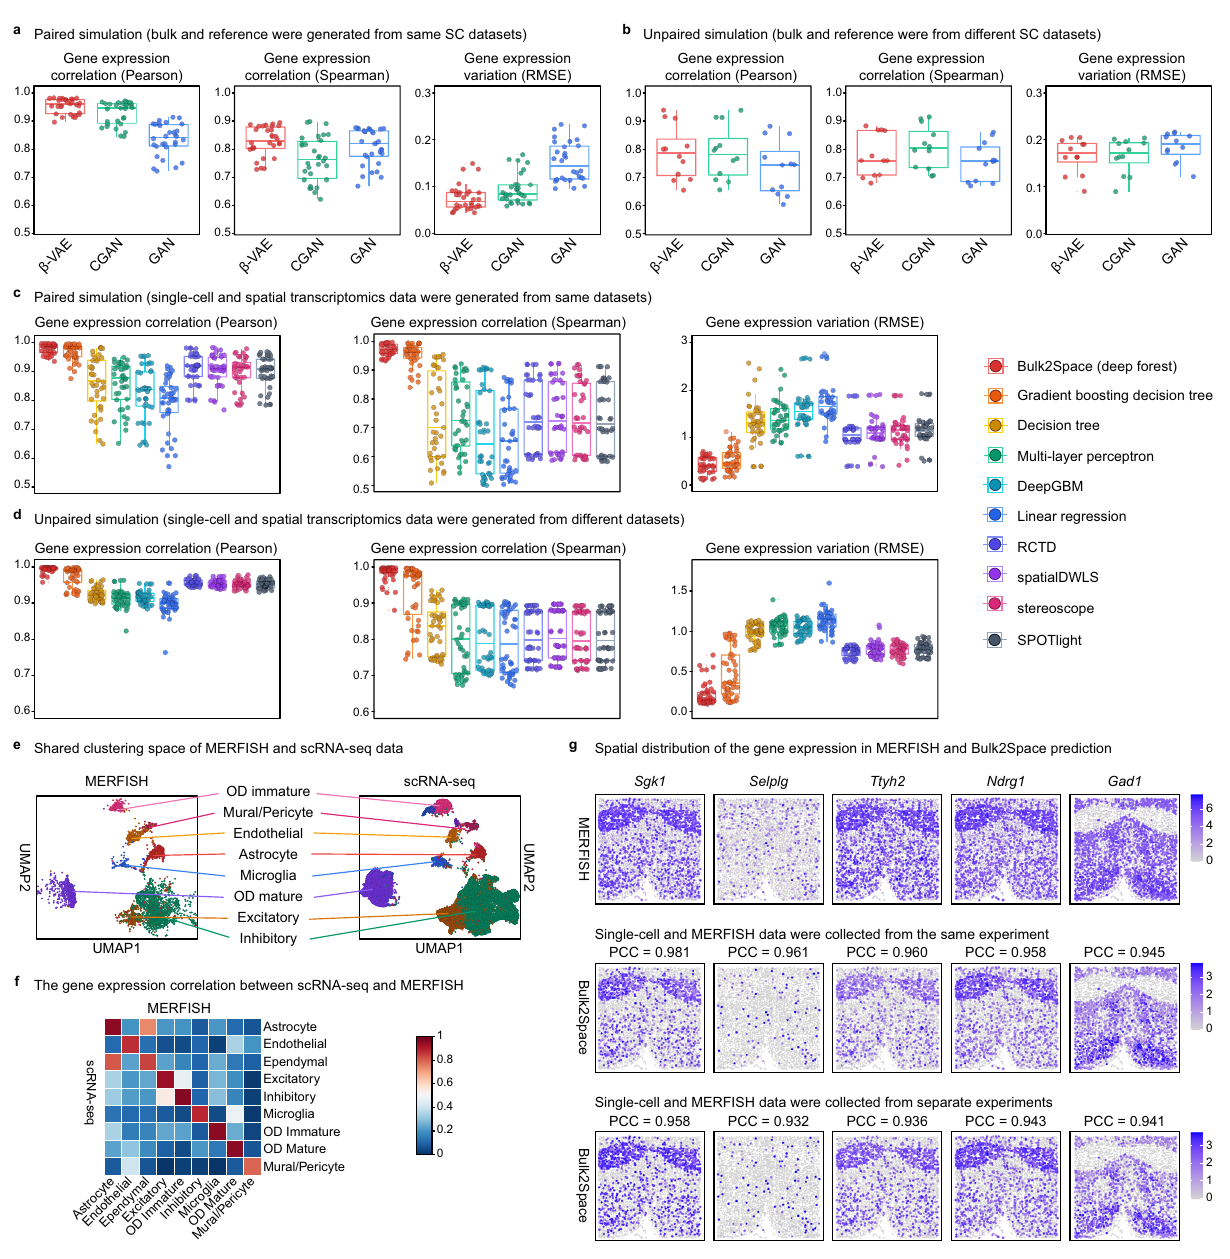
Fig. 2 | Benchmark test for Bulk2Space. a Gene expression correlation (Pearson correlations, left, and Spearman correlations, middle) and gene expression varia- tion(RMSE,right)of threemethods,namely, Bulk2Space( β -VAE),GAN, and CGAN, using paired simulation data ( n = 30). Each point represented a simulated dataset. Data are presented as boxplots (minima, 25th percentile, median, 75th percentile, andmaxima). b Geneexpressioncorrelationandgeneexpressionvariationofthree methods with unpaired simulation data ( n = 12). Data are presented as boxplots (minima, 25th percentile, median, 75th percentile, and maxima). c Benchmark test for 10 spatial mapping methods (from left to right, Bulk2Space (deep forest), gra- dient boosting decision tree, decision tree, multi-layer perceptron, DeepGBM, lin- ear regression, RCTD, spatialDWLS, stereoscope, and SPOTlight) using paired simulation data ( n = 50). Data are presented as boxplots (minima, 25th percentile,